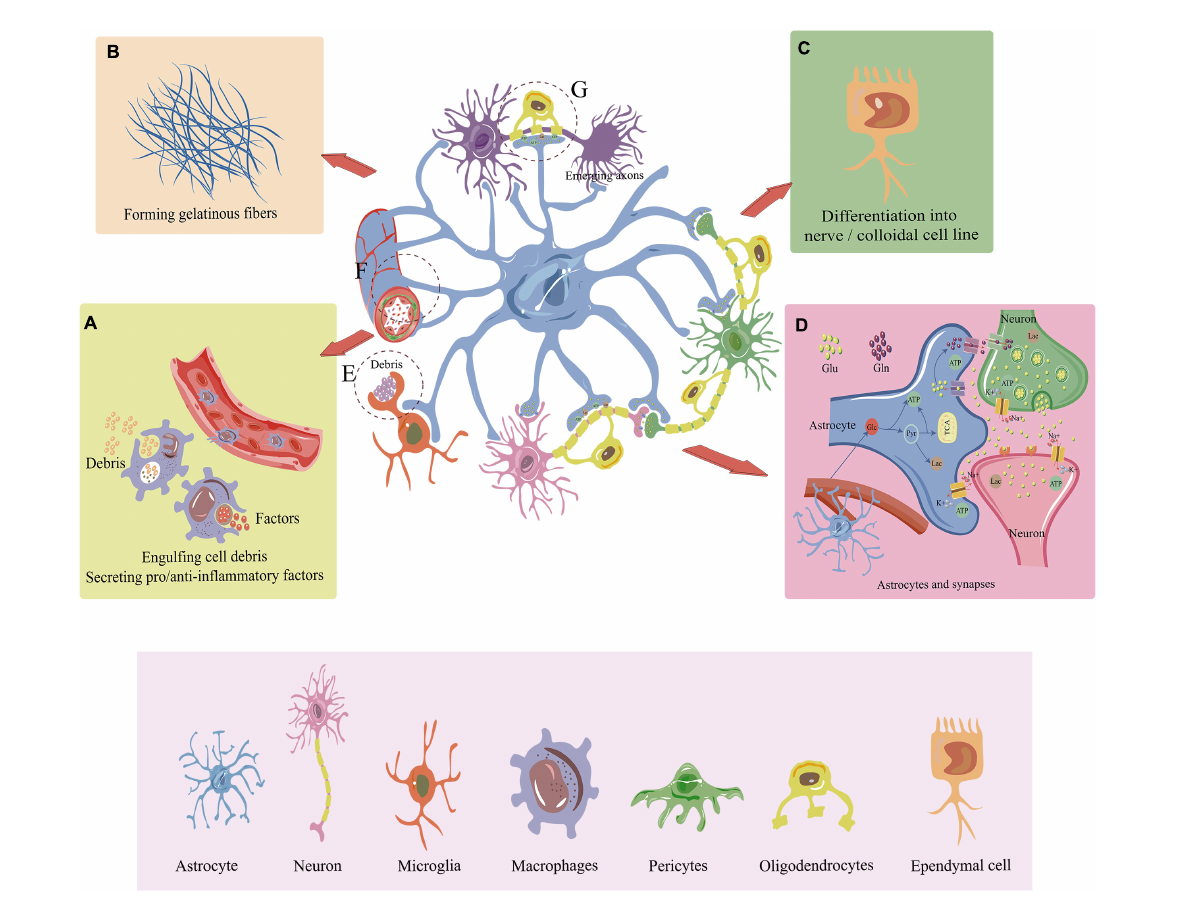
FIGURE2 Major role of endogenous cells in the repair of SCI. (A) Under the influence of chemokines, macrophages migrate to the site of injury with outstretched peduncles to engulf cell debris and remnant tissues. They also stimulate relevant pro-inflammatory and anti-inflammatory molecules involved in the repair of spinal cord injuries. (B) Astrocytes and pericytes can secrete fibronectin to promote glial. (C) Ependymal cells are the major endogenous stem cells that differentiate into neural/colloidal cell lines that includes neurons, oligodendrocytes, and astrocytes. (D) Astrocytes take up glucose from blood vessels and convert it to lactate and ATP to provide energy for peripheral neurons. Astrocytes also facilitate the transmission of neurotransmitters such as glutamate, enhancing the signal communication between neurons. In addition, astrocytes maintain ion homeostasis inside and outside the cell. (E) Microglia engulf cellular debris and residual tissue at the site of SCI. (F) Astrocytes control blood flow by interacting with blood arteries. Pericyte can promote vascular remodeling, maintain normal vascular structure and stabilize the BSCB during SCI repair. (G) Oligodendrocytes help myelin regenerate, and astrocytes also give myelin and axon regeneration energy. SCI, Spinal cord injury; BSCB, Blood-spinal cord barrier; Glu, Glucose; Glu, Glutamate; Gln, Glutamine; TAC, Tricarboxylic acid cycle; Lac, Lactate; Pyr, Pyruvic